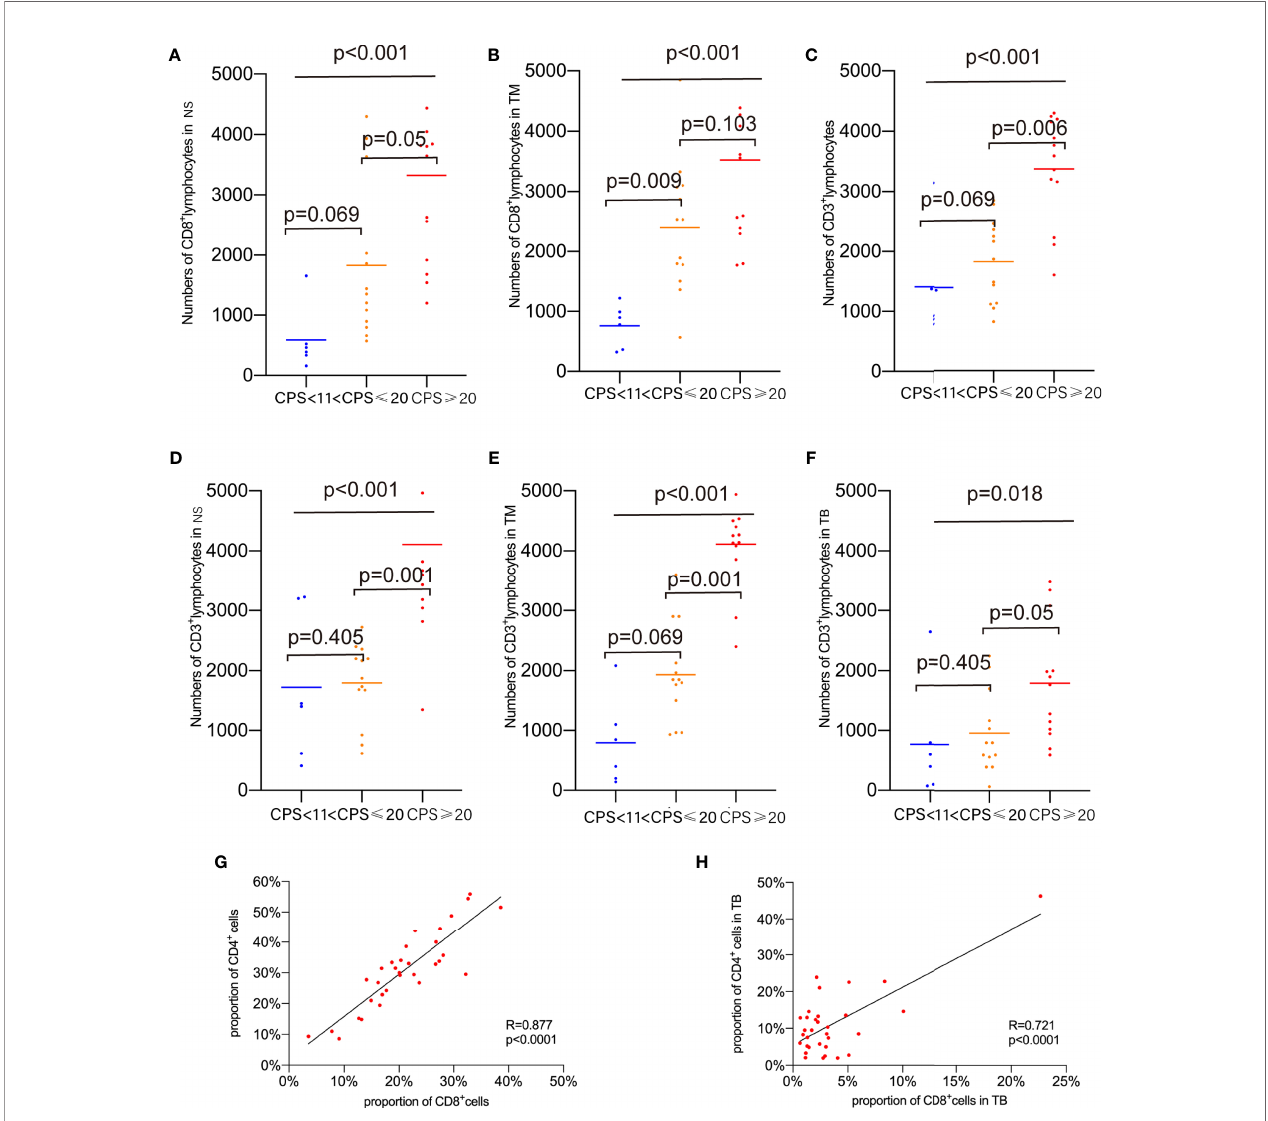
FIGURE 5 | Proportions of marker-positive cells according to CPS levels. (A) Comparison of the proportion of CD8 + cells in NS. (B) Comparison of the proportion of CD8 + cells in TM. (C) Comparison of the proportion of CD3 + cells in whole area of slides. (D) Comparison of the proportion of CD3 + cells in NS. (E) Comparison of the proportion of CD3 + cells in TM. (F) Comparison of the proportion of CD3 + cells in TB. (G) Correlations of CD8 + cell and CD4 + cells in whole area of slides. (H) Correlations of CD8 + cell and CD4 + cells in